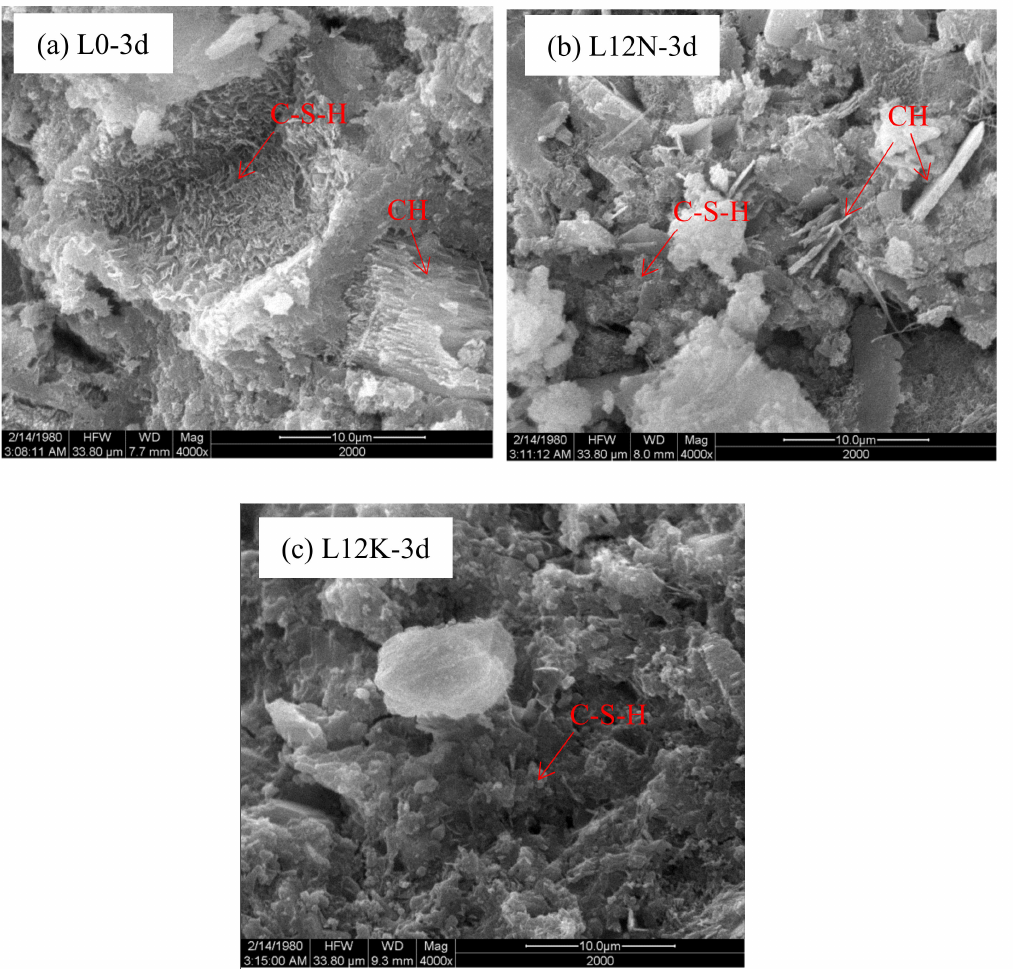
Figure 17. SEM map of LHPC mortars with different content and different types of alkali sulfates (4000 × ). ( a ) LHPC pastes with alkali content of 0.4% at 3d; ( b ) LHPC pastes with alkali content of 1.2% (added with Na 2 SO 4 ) at 3d; ( c ) LHPC pastes with alkali content of 1.2% (added with K 2 SO 4 ) at 3d.